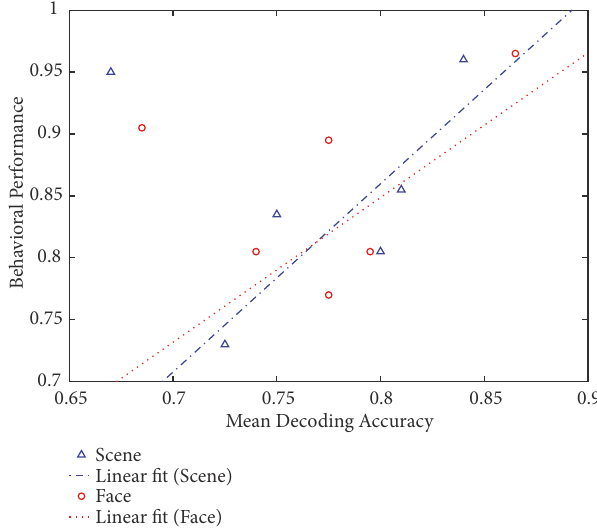
Figure3:BehavioralperformanceversusmeanEEGdecodingaccu- racy across all participants. The outliers were eliminated to illustrate the relationship between decoding performance and participants’ behavioral